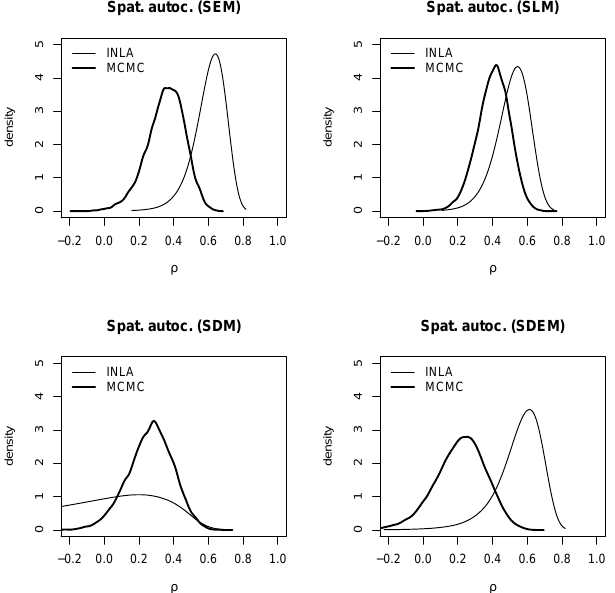
Figure 6. Posterior marginal of the spatial autocorrelation parameters for different models for INLA and MCMC, Katrina business data. Differences in the estimates can be explained by the different link functions used in the model fit with MCMC and